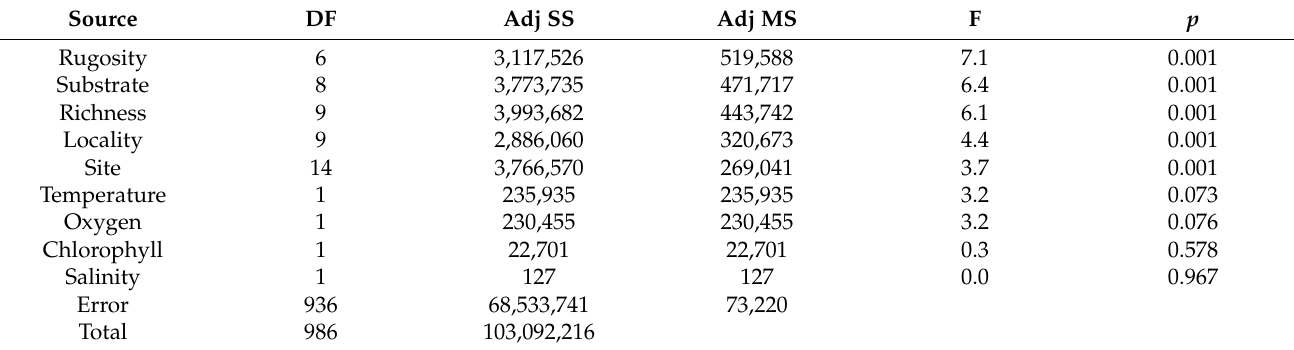
Table 4. GLM ANOVA showing complex influences on zoobenthic carbon storage (stock) around the Tristan da Cunha region. Seabed roughness (rugosity), substrate, richness (number of functional groups) and spatial factors (locality and site) are significant but only explain a moderate part of data